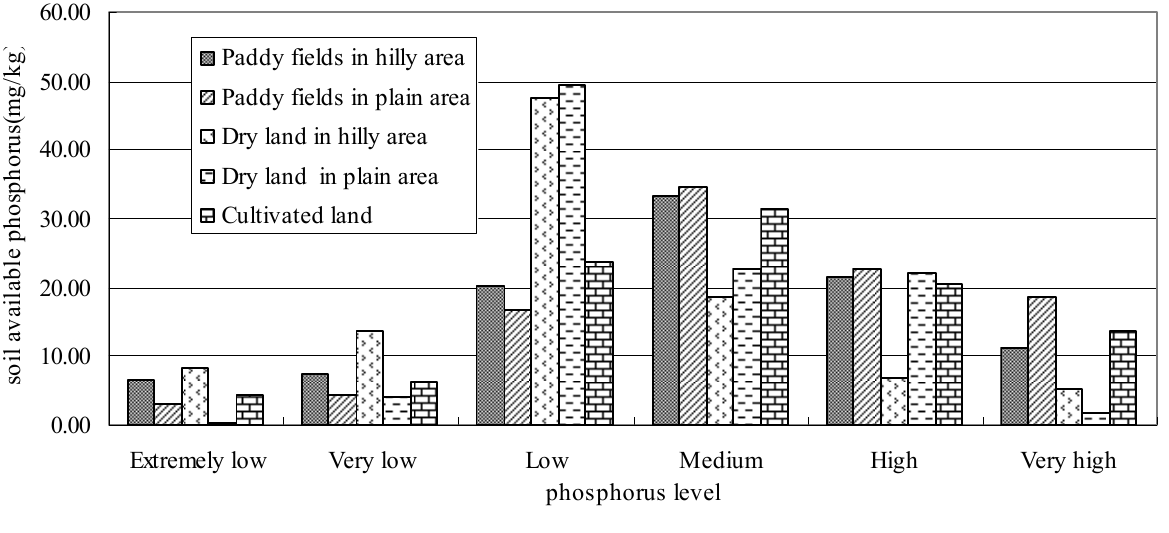
Figure 6. Area percentage of different soil available phosphorus levels in different cultivated land types.